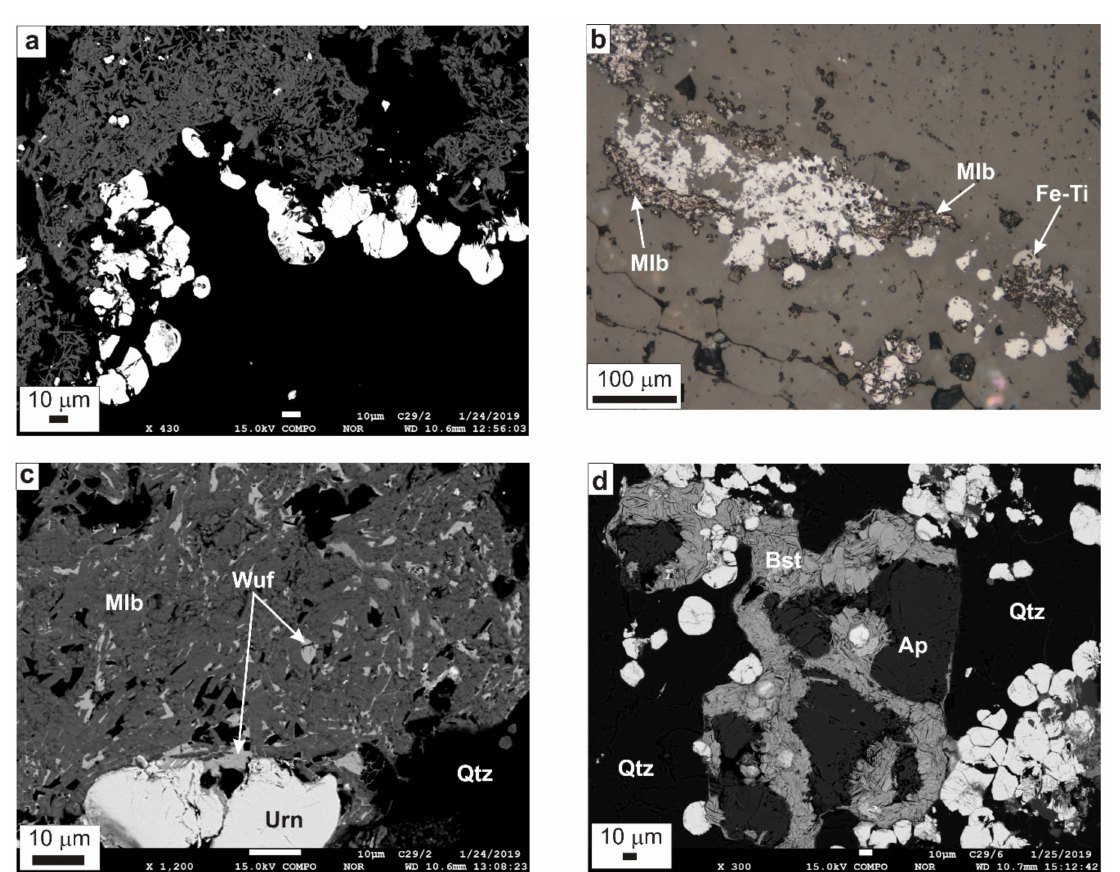
Figure 4. ( a ) Uraninite (white) aggregates on the border of the molybdenite vein (dark grey) and is also enclosed in molybdenite. The quartz is black. ( b ) Accumulation of uraninite (light grey) rimmed by fine-grained molybdenite (Mlb). At the bottom right are Fe-Ti oxides (Fe-Ti). The surroundings are quartz (dark grey). ( c ) Cavities and cracks in molybdenite (Mlb) aggregate are partially filled by wulfenite (Wuf), which also partially rims uraninite globules (Urn). The surrounding phase is quartz (Qtz). ( d ) Fluorapatite (Ap) is accompanied by uraninite (white). Supergene uranyl mineral, bassetite (Bst), encloses both minerals and also fills cracks in fluorapatite. The host mineral is quartz (Qtz). Pictures a, c, d—BSE (photo: T. Mikuš); picture b—reflected light, PPL (photo: Š.